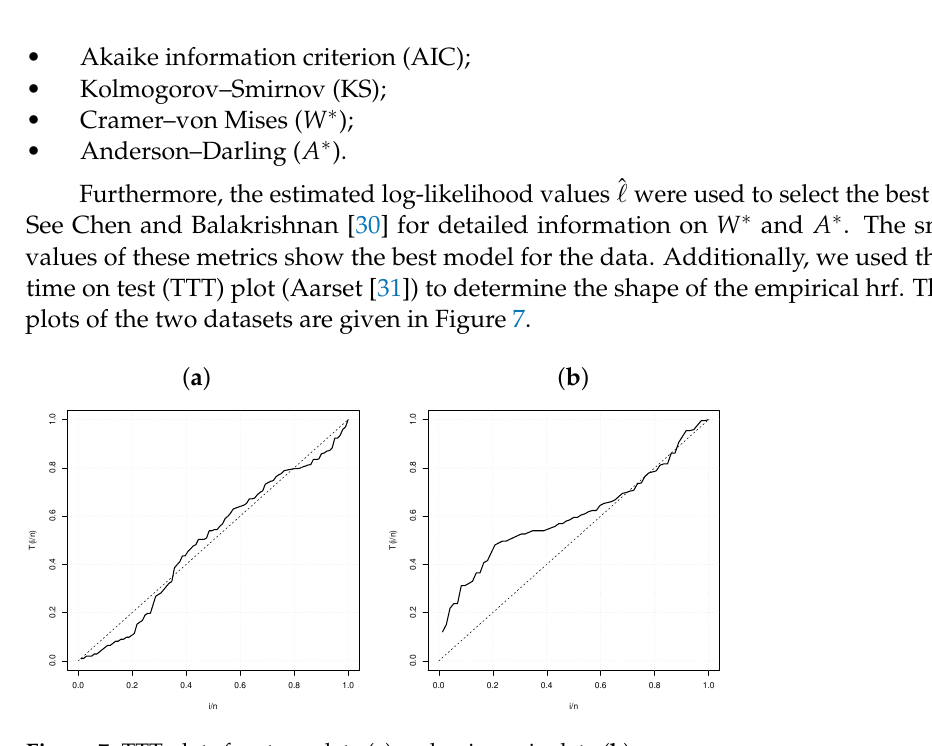
Figure 7. TTT plots for stress data ( a ) and guinea pig data ( b ).